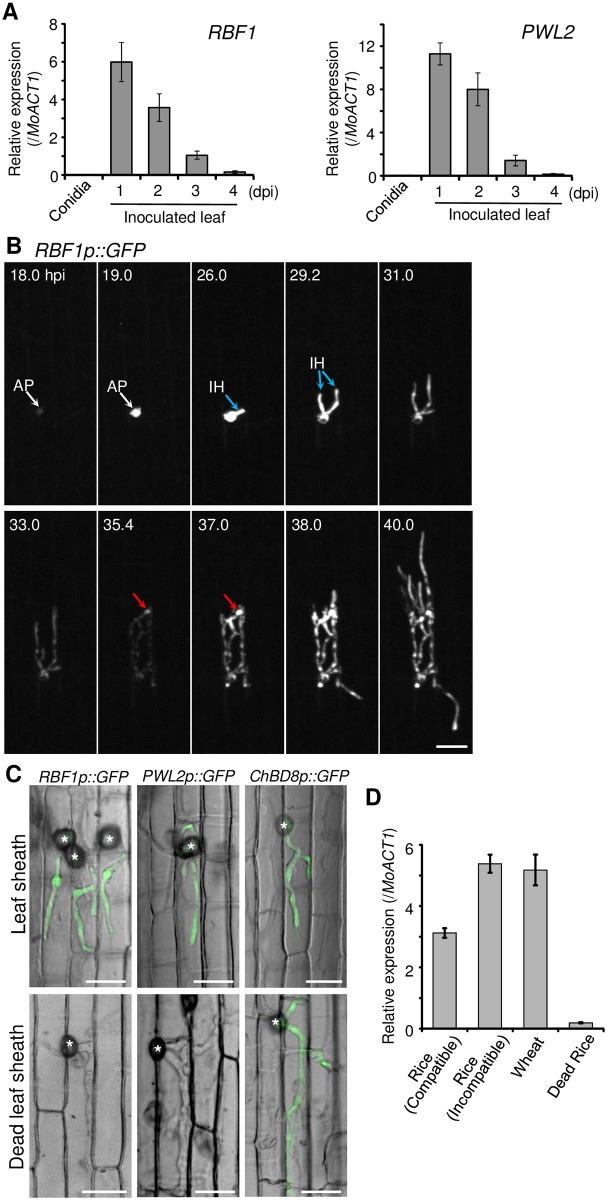

RBF1 expression is activated when Magnaporthe oryzae invades living plant cells.
(A) Quantitative RT-PCR analysis of RBF1 and PWL2 expression in conidia and inoculated rice leaf blades. The vertical axis indicates the amount of transcripts relative to that from the M. oryzae actin gene (MoACT1). Data are represented as mean values ± standard error (SE) (n = 3 plants). dpi, days post inoculation. (B) The dynamic expression of RBF1. RBF1 expression during the infection process in the rice leaf sheath epidermis was monitored by a long-term time-lapse imaging method using a fungal line transformed with RBF1p::GFP. After appressoria formation, GFP signals were captured at 20-min intervals. The z-series of optical sections corresponding to the outer half of the inner epidermal cells were stacked to generate maximum-intensity projection images. Images displayed were selected from S1 Movie. White and blue arrows indicate the induction of GFP expression in the appressorium and the invasive hyphae, respectively. Red arrows indicate the re-induction of the GFP expression in the hyphal cell that was about to invade the neighboring cell. hpi, hours post inoculation. Bar = 20 μm. (C) Confocal images of M. oryzae transformants introduced with RBF1p::GFP, PWL2p::GFP, or ChBD8p::GFP growing in living rice leaf sheaths (upper) and dead rice leaf sheaths (lower) at 24 hpi. GFP images were merged with differential interference contrast images. Asterisks indicate appressoria. Bar = 20 μm. (D) Quantitative RT-PCR analysis of RBF1 expression in the inoculated living leaf blades of rice and wheat, and dead rice leaf blades at 24 hpi. The vertical axis indicates the amount of transcripts relative to that from the M. oryzae actin gene (MoACT1). Data are represented as mean values ± SE (n = 4 plants).